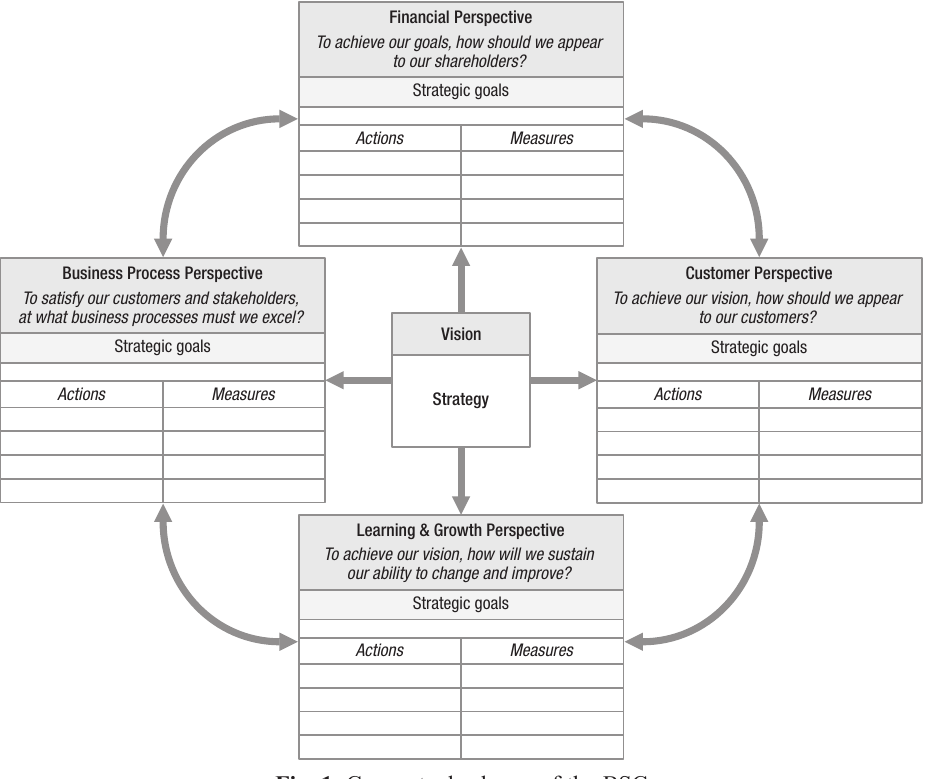
Fig. 1. Conceptual scheme of the BSC Source : Adapted from Kaplan and Norton